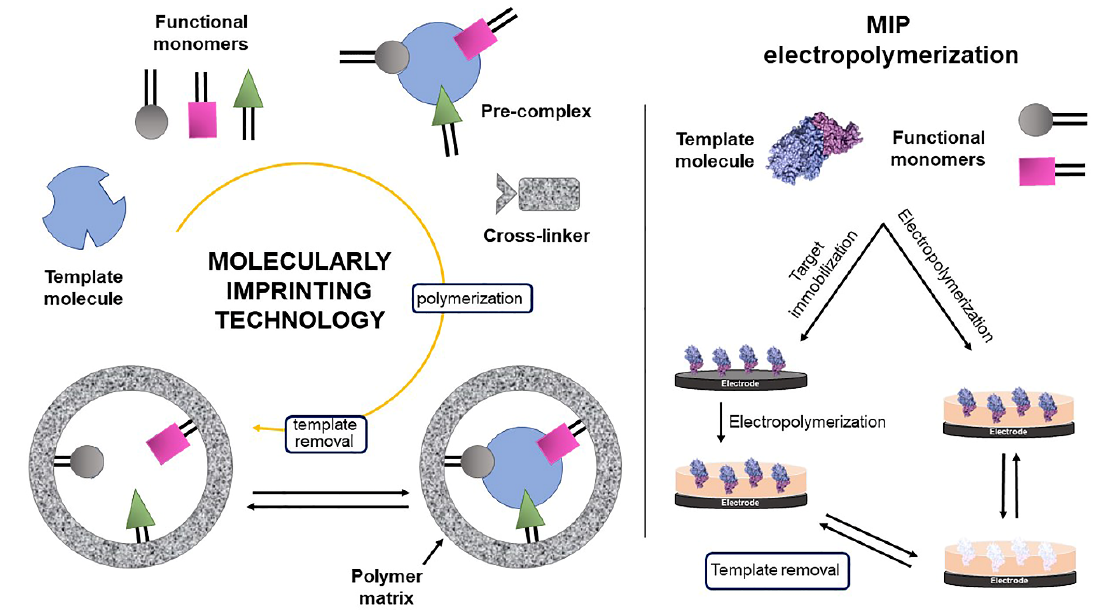
Scheme 3. Schematic diagram of the molecular imprinting process.